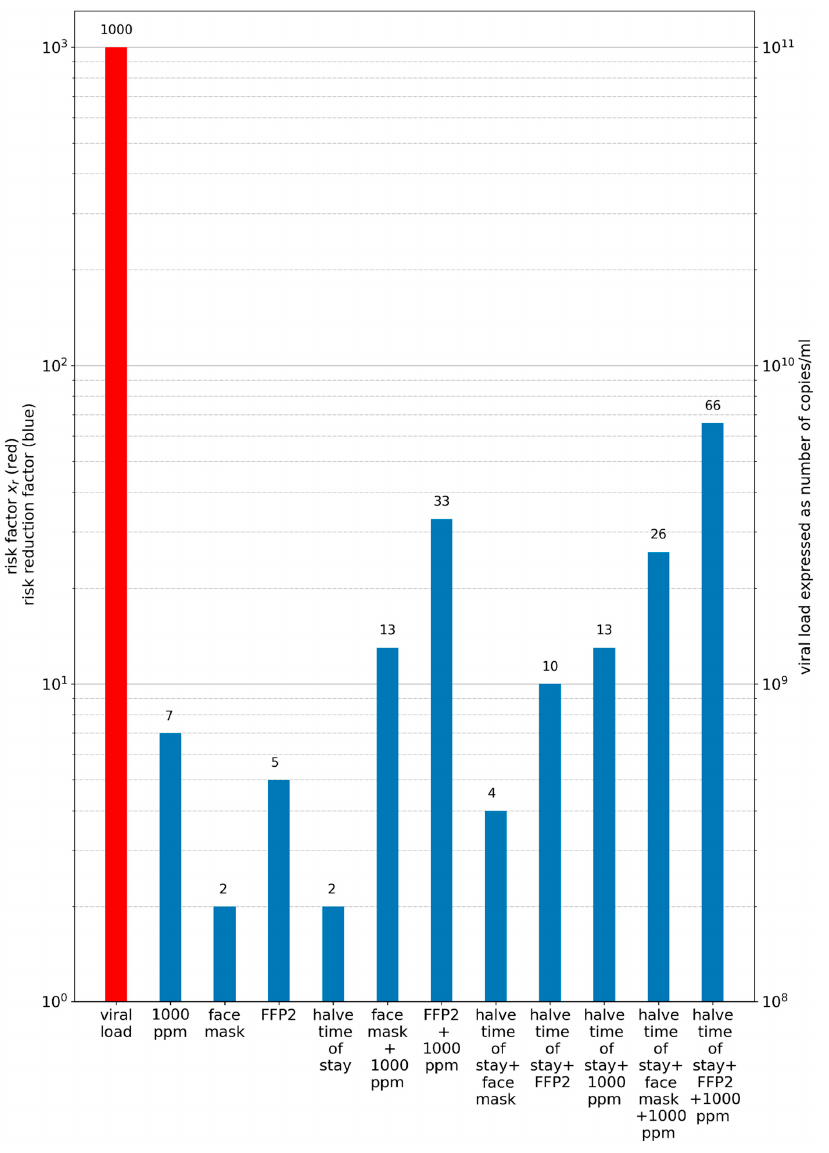
Figure 10. Influence of different preventive measures on the risk of an outbreak. The red bar represents the viral load and the resulting risk factor (Equation (37)). The blue bars illustrate different combinations of preventive measures in the form of a risk reduction factor (also according to Equation (37)).